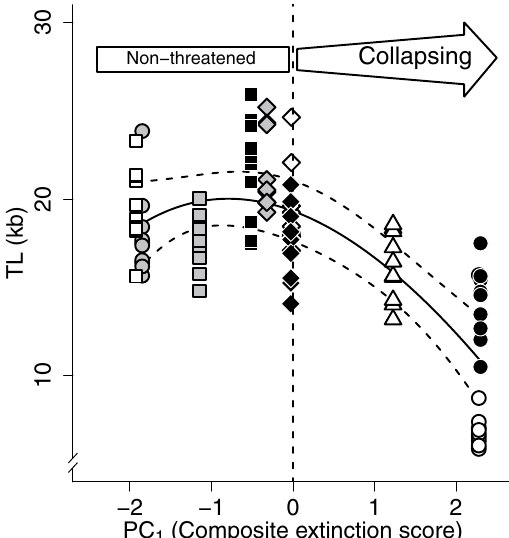
Figure 4. Non-linear relationship between telomere length (TL) and population extinction risk score. A population extinction risk score was assessed from the first axis (PC 1 ) of a principal component analysis, including the main determinant of population collapse (the relative change of abundance, T min , and altitude). For PC 1 < 0, the populations are non-threatened, and when PC 1 > 0, the risk of collapsing progressively increases (Bas: grey circle, Bel: grey square, Car: white circle, Cha: white diamond, Com: black diamond, Jon: grey diamond, Joc: white square, Laj: black square, Mon: black circle, and Puy: white triangle). The predictions of the selected model were fitted on the data (solid line) together with the 95% confidence interval (dashed lines). A similar pattern and result was obtained when relative change in abundance ( Δ abundance) was used as a covariate instead of PC 1